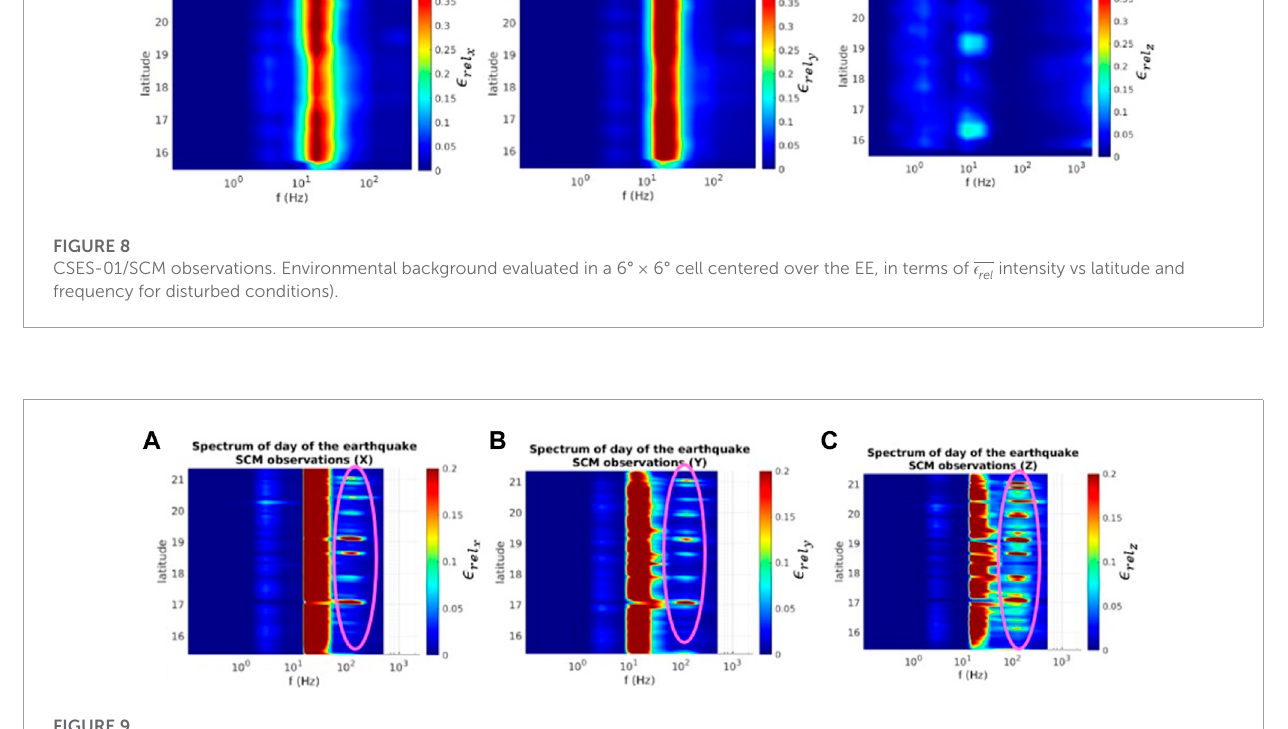
FIGURE 9 CSES-01/SCM observations on 14 August 2021, 6 hours before the event, when the satellite flew over the EE. In addition to the second Schumann resonance, another signal appears with more evidence in the z component.